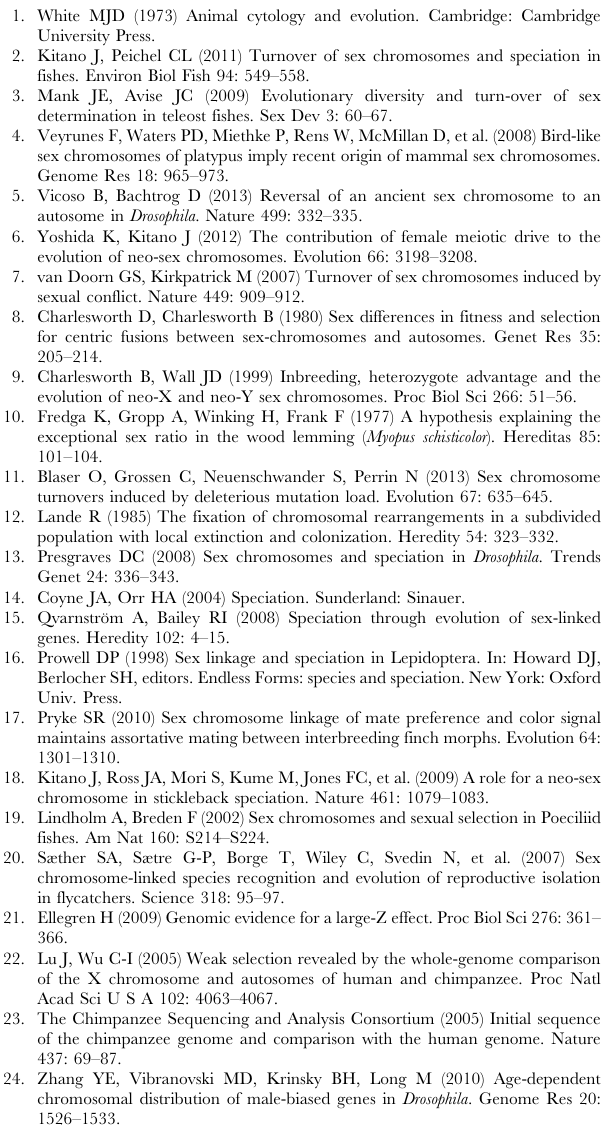
on LG9 and LG19 are highlighted with pink and green colors, respectively. Genome-wide significance thresholds ( P , 0.05) were determined with 1000 bootstrap permutations and indicated with dashed lines. The one locus model of R/qtl was used. (C) Significant QTL were found for hybrid courtship abnormality. The upper diagonal indicates the LOD score comparing the model including the interaction term to the model without the interaction, while the lower diagonal indicates the LOD score comparing the full model with the interaction term to the null model (i.e., no QTL). The right bar indicates the scales of upper (left side) and lower diagonal (right side). Table S1 Number of putatively X-specific, Y-specific and shared SNPs. Table S2 Significant QTL identified in the Japanese crosses.